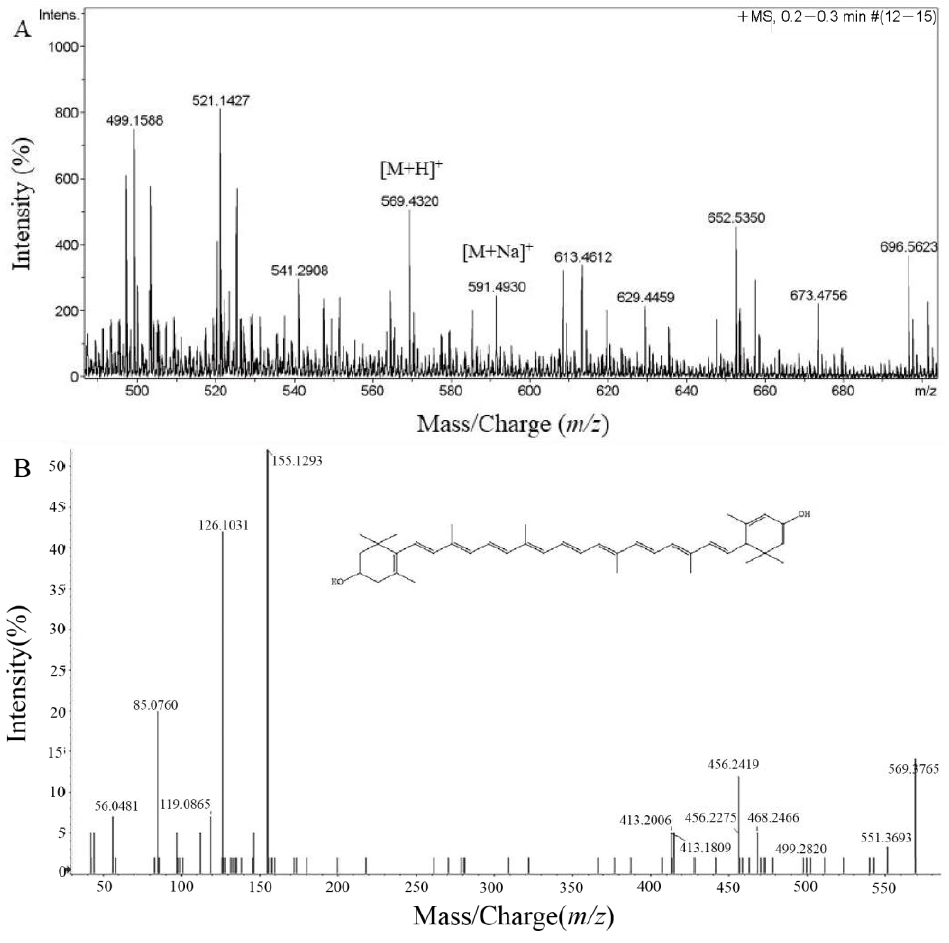
Figure 4. MS ( A ) and MS/MS ( B ) spectrum of purified pigment from G. rubripertincta GH-1.